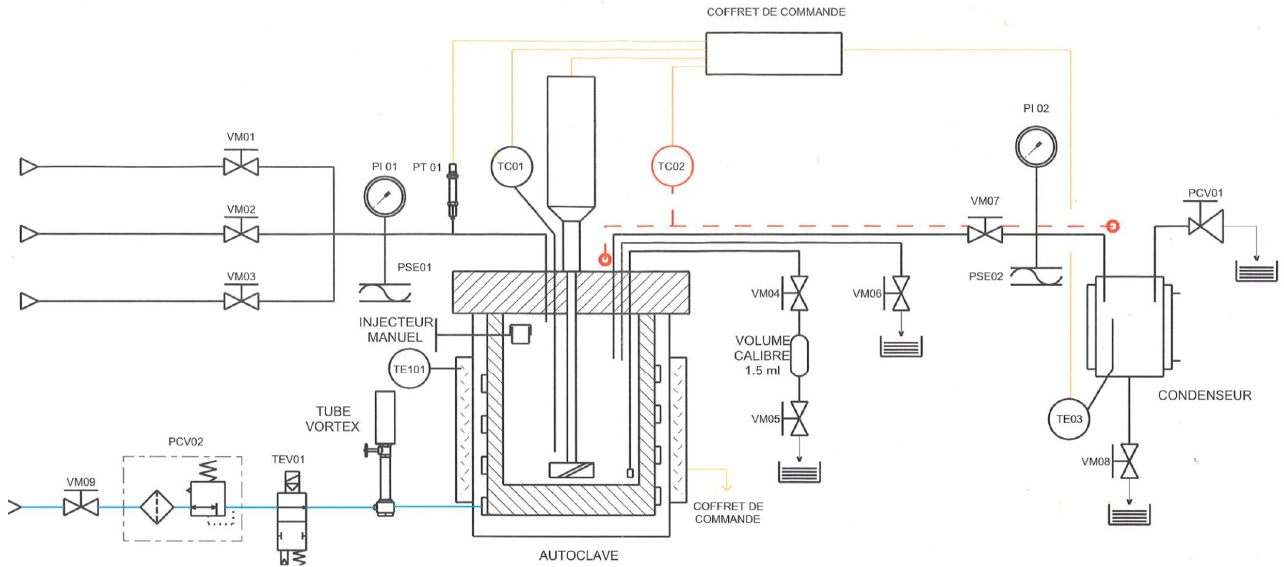
Figure 2. Supercritical water gasification reactor provided by Top-Industrie (France).